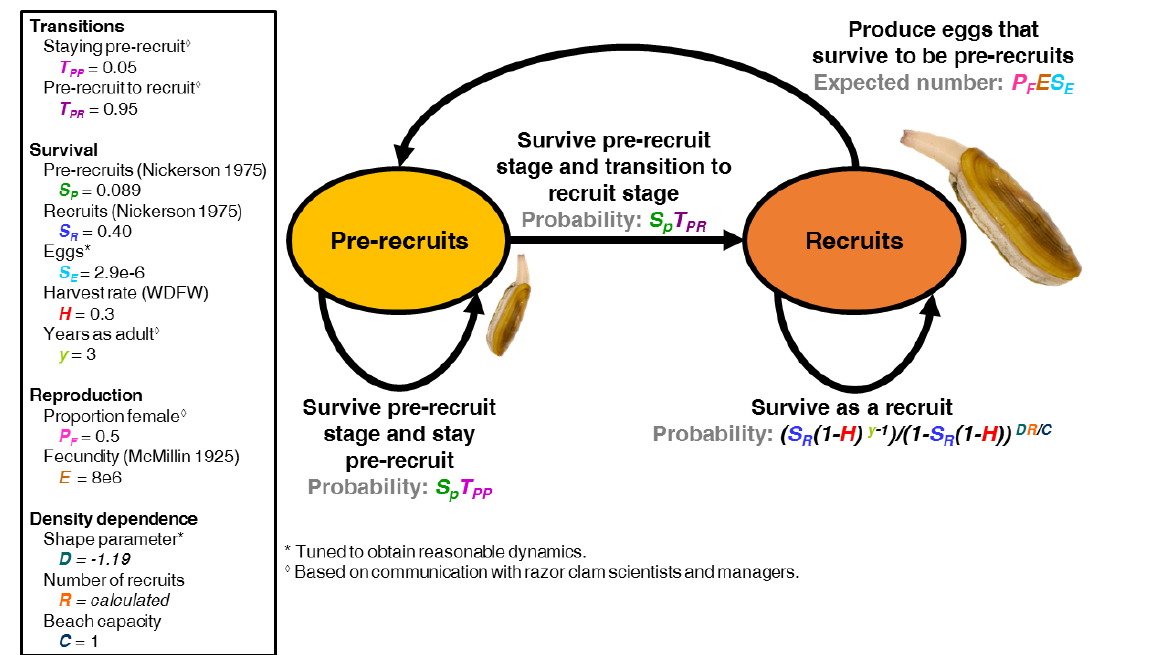
Figure A5.1. Stage-based razor clam population model used to simulate potential impacts of the Quinault’s perceived risks. We show transition probabilities between the pre-recruit and recruit stages, survival rates at each stage, reproduction parameters, and parameter values for density- dependence and beach